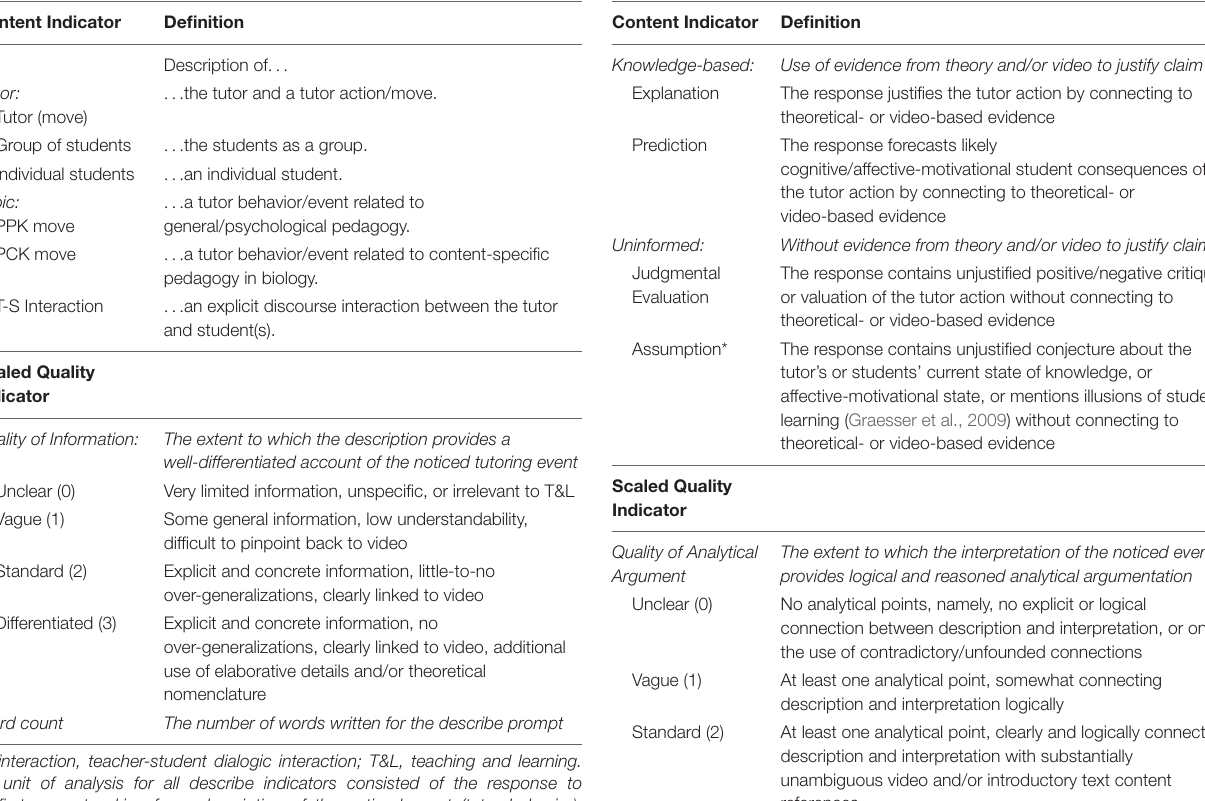
TABLE 1 | Describing codes for (scaled) qualitative content analysis. TABLE 2 | Interpreting codes for (scaled) qualitative content